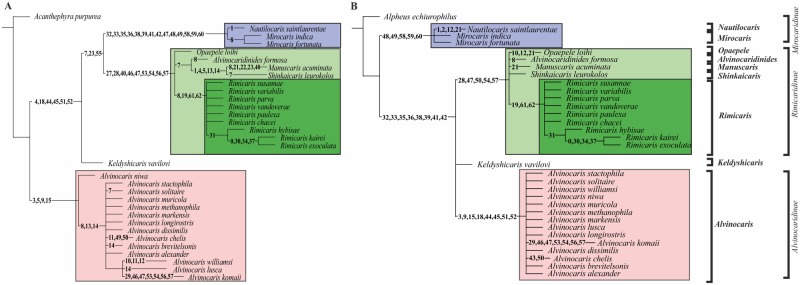
Strict consensus trees of Alvinocarididae and synapomorphies (numbers in circles).A, analysis 1 with Acanthephyra purpurea as the outgroup. B, analysis 2 with Alpheus echiurophilus as the outgroup. Supported clades are marked by different colors: Mirocaridinae (blue), Alvinocaridinae (pink), Rimicaridinae (light green), Rimicaris (green).